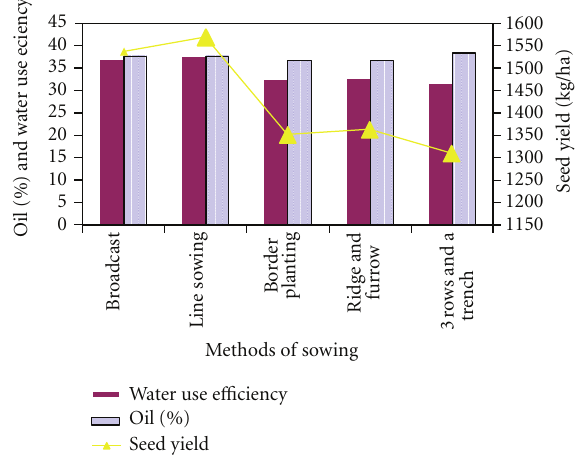
Figure 1: Seed yield, water use e ffi ciency, Kg/ha-mm (WUE), and oil content of mustard ( Brassica juncea ) as influenced by various planting